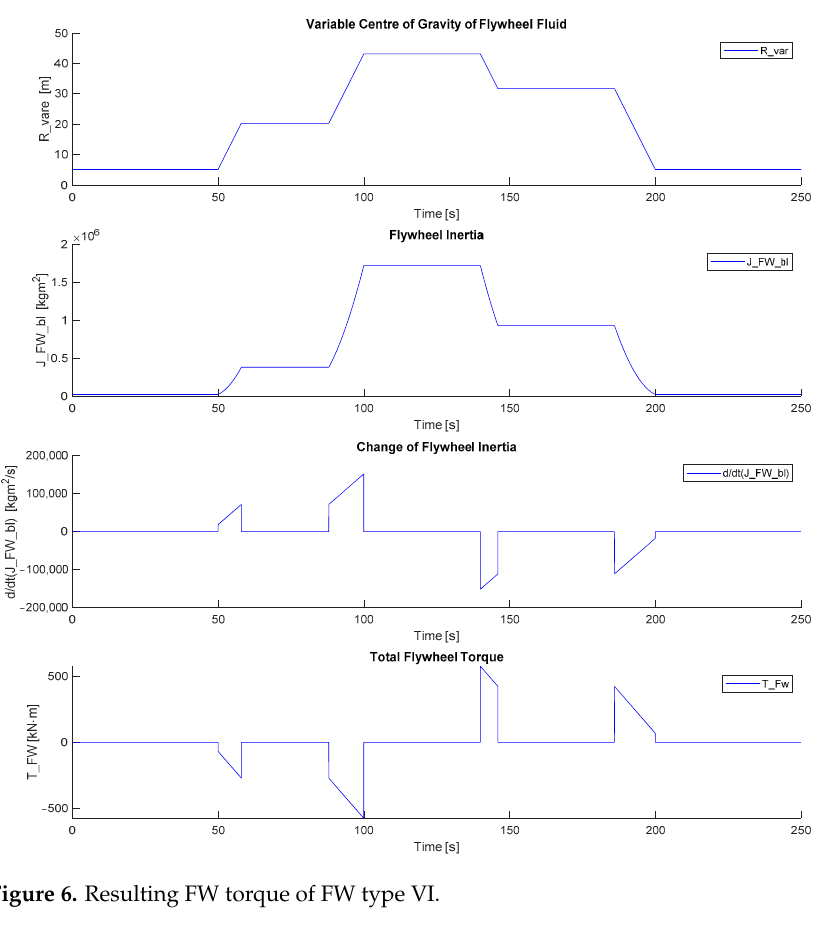
Figure 6. Resulting FW torque of FW type VI.